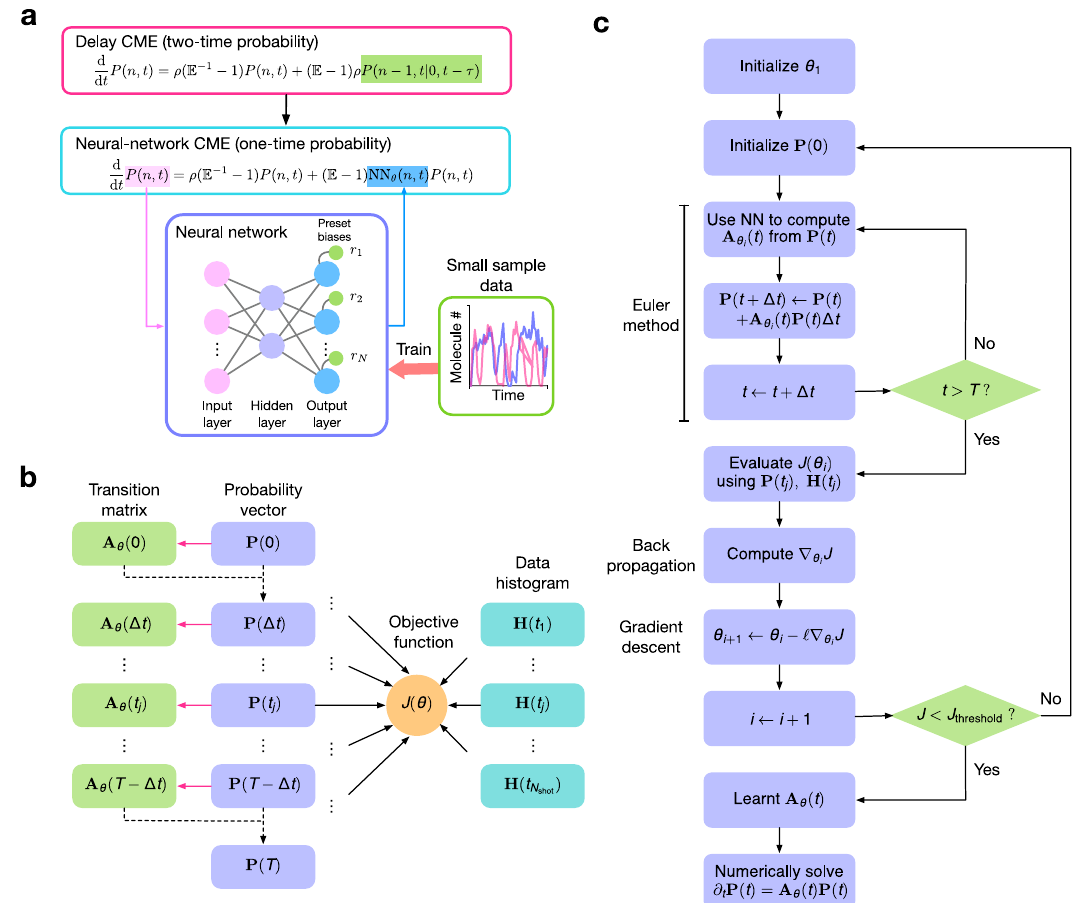
Fig. 1 The ANN-aided stochastic model approximation. a Illustration of the key idea behind the method, namely the ANN-aided mapping of a delay master equation that is in terms of the two-time probability distribution by the simpler neural-network chemical master equation (NN-CME) whose terms are only a function of the current time. b Illustration of the procedure behind the calculation of the transition matrix and the objective function. For a given set of weights and biases of the ANN (denoted by θ ), taking as input P ( t ), the ANN ’ s output gives the transition matrix elements A θ ( t ), which then by means of the Euler method (or more advanced differential equation solvers) is used to predict the distribution at the next time step P ( t + Δ t ). Note that magenta arrows show the ANN computation while the black dashed arrows show the use of the Euler method. Stochastic simulations that sample the solution of the delay master equation are used to produce histograms at several time points H ( t ); fi nally the distance J ( θ ) is calculated between the latter and P ( t ) (evaluated at the same time points). c Flowchart illustrating all the steps in ANN training. If the objective function calculated as shown in ( b ) is above a threshold then the weights and biases of the ANN are updated using back propagation followed by gradient descent; this is repeated until the objective function is below a